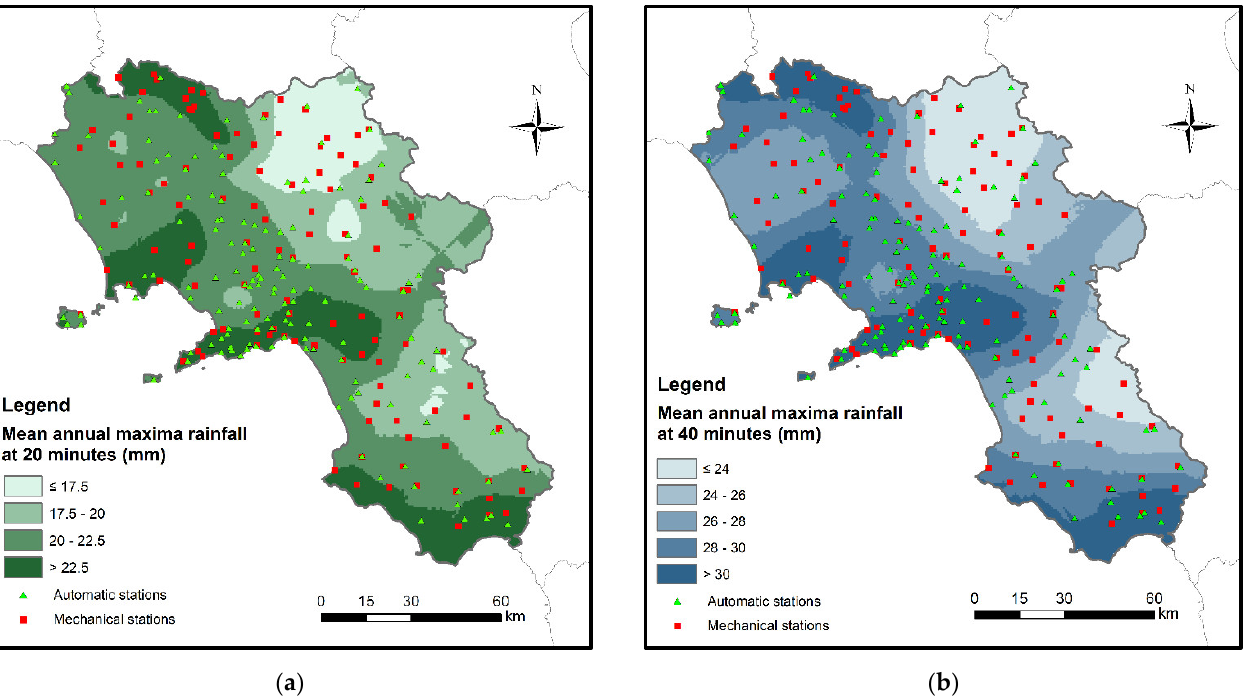
Figure 5. Maps of the mean annual rainfall maxima at ( a ) 20 minutes and ( b ) 40 minutes. The maps were obtained by interpolating observed data from both the automatic stations belonging to the newest network and from mechanical stations belonging to the historical network, then computed using the proposed hybrid regional procedure.